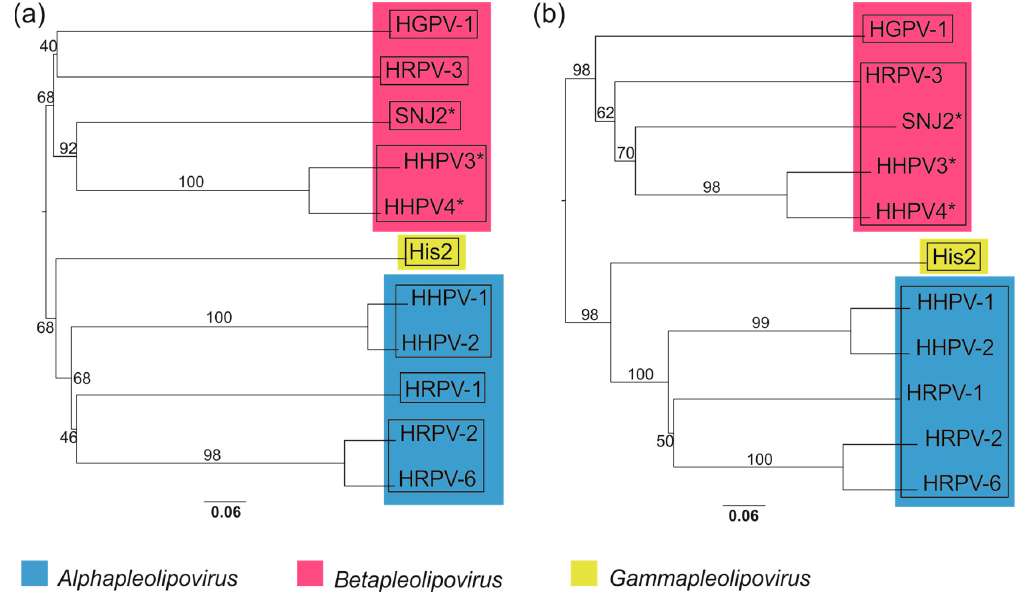
Figure 6. Phylogenomic Genome BLAST Distance Phylogeny (GBDP) trees of the whole genomic sequences of the members and putative members of the family Pleolipoviridae at the ( a ) nucleotide and ( b ) amino acid levels. Viruses classified or proposed to be classified (marked by asterisks) into three genera of the family Pleolipoviridae are marked with different colours (see the colour code). Genera yielded by OPTSIL clustering are shown as squares. The branch lengths are scaled in terms of the GBDP distance formula D0 in ( a ) and the GBDP distance formula D6 in ( b ) [49]. The trees and OPTSIL clusters were obtained using the VICTOR web service [49].